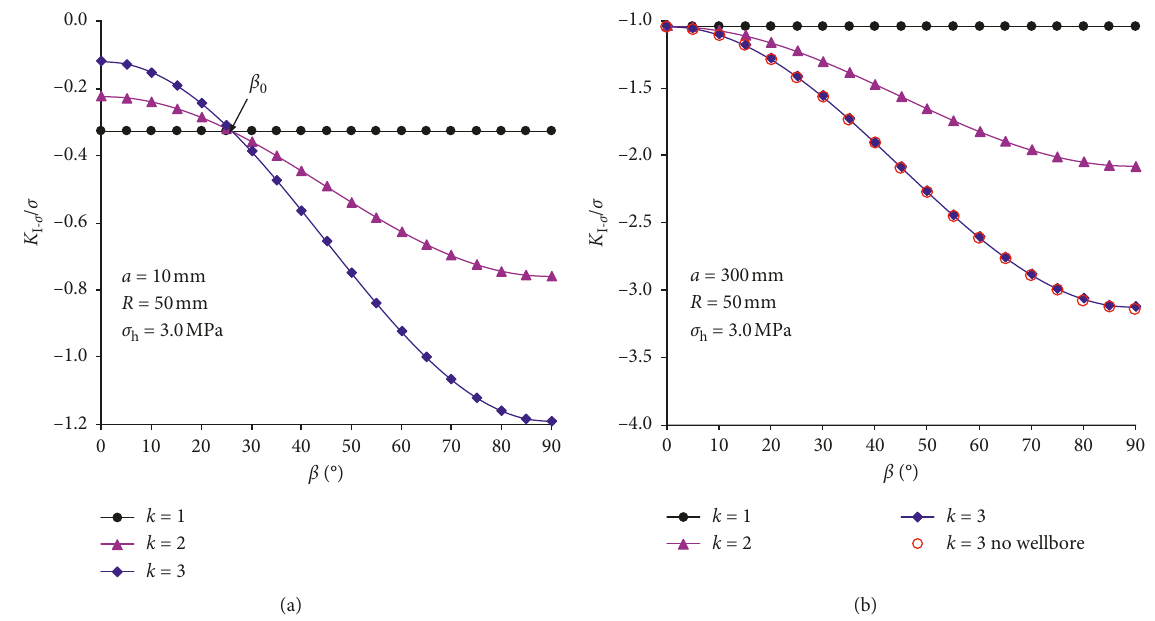
Figure 9: Influence of stress anisotropy coefficient on the mode-I stress intensity factor K